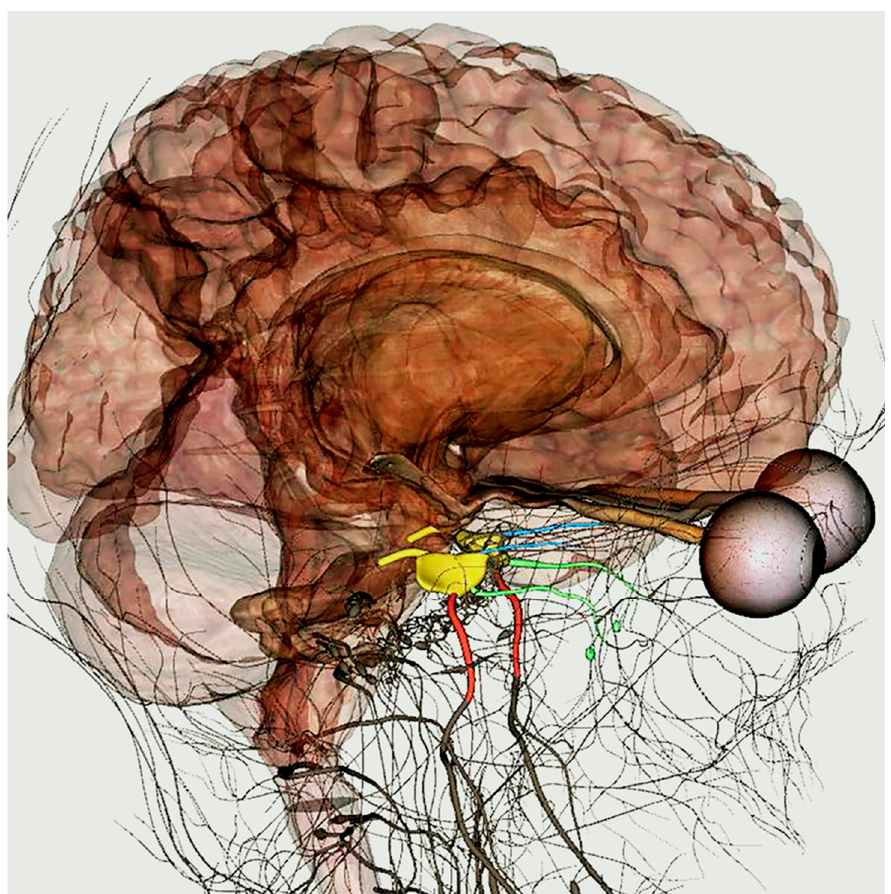
Figure 4. Trigeminus nerve with its semilunar ganglion (yellow) and its branches: mandibular (red), maxillary (green), and ophthalmic (light blue). To identify the origin of this nerve, the organs of the central nervous system were made transparent by appropriate filters.